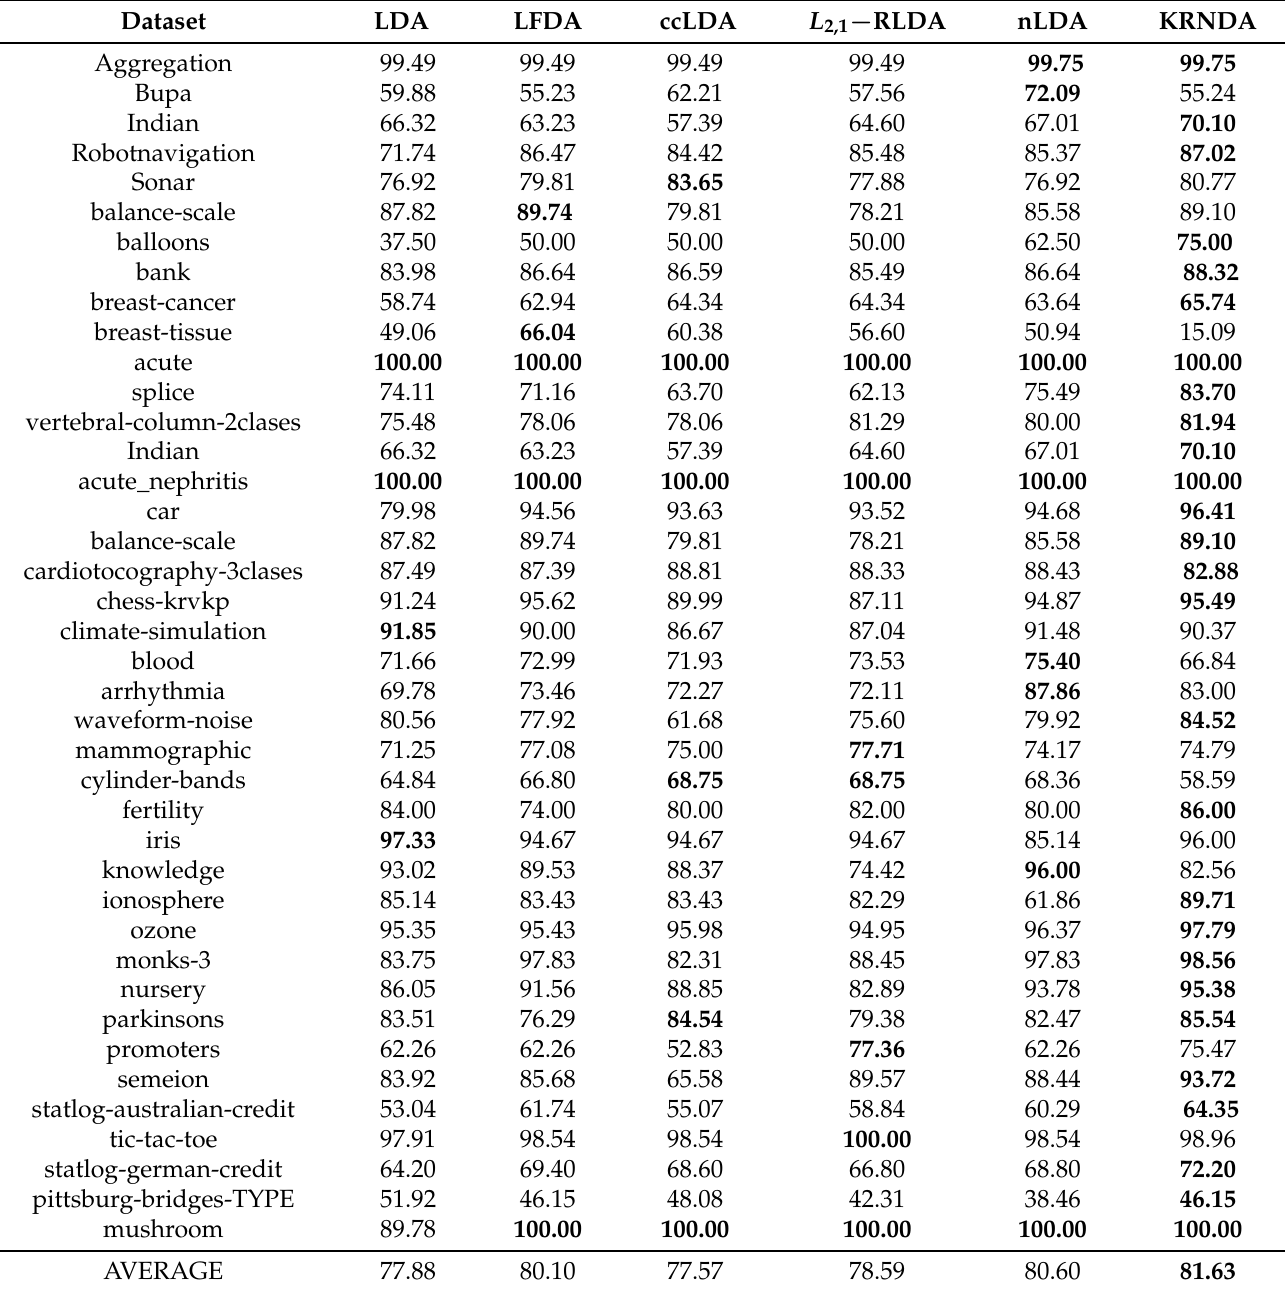
Table 7. The classification accuracy (%) of different discriminators on UCI benchmark